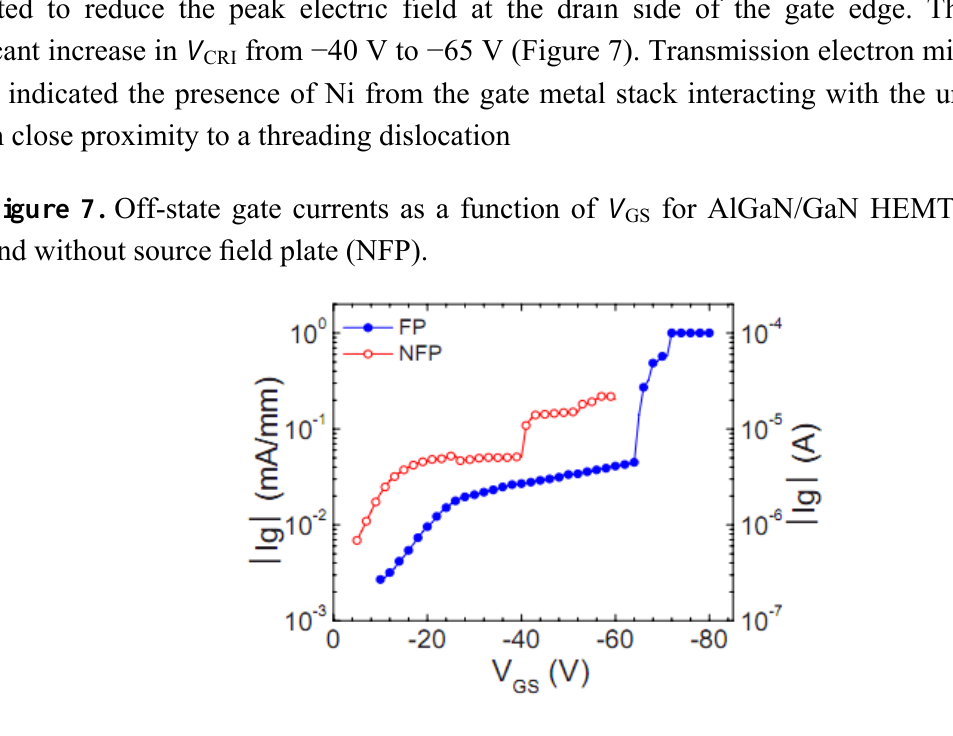
for AlGaN/GaN HEMT with (FP) GS